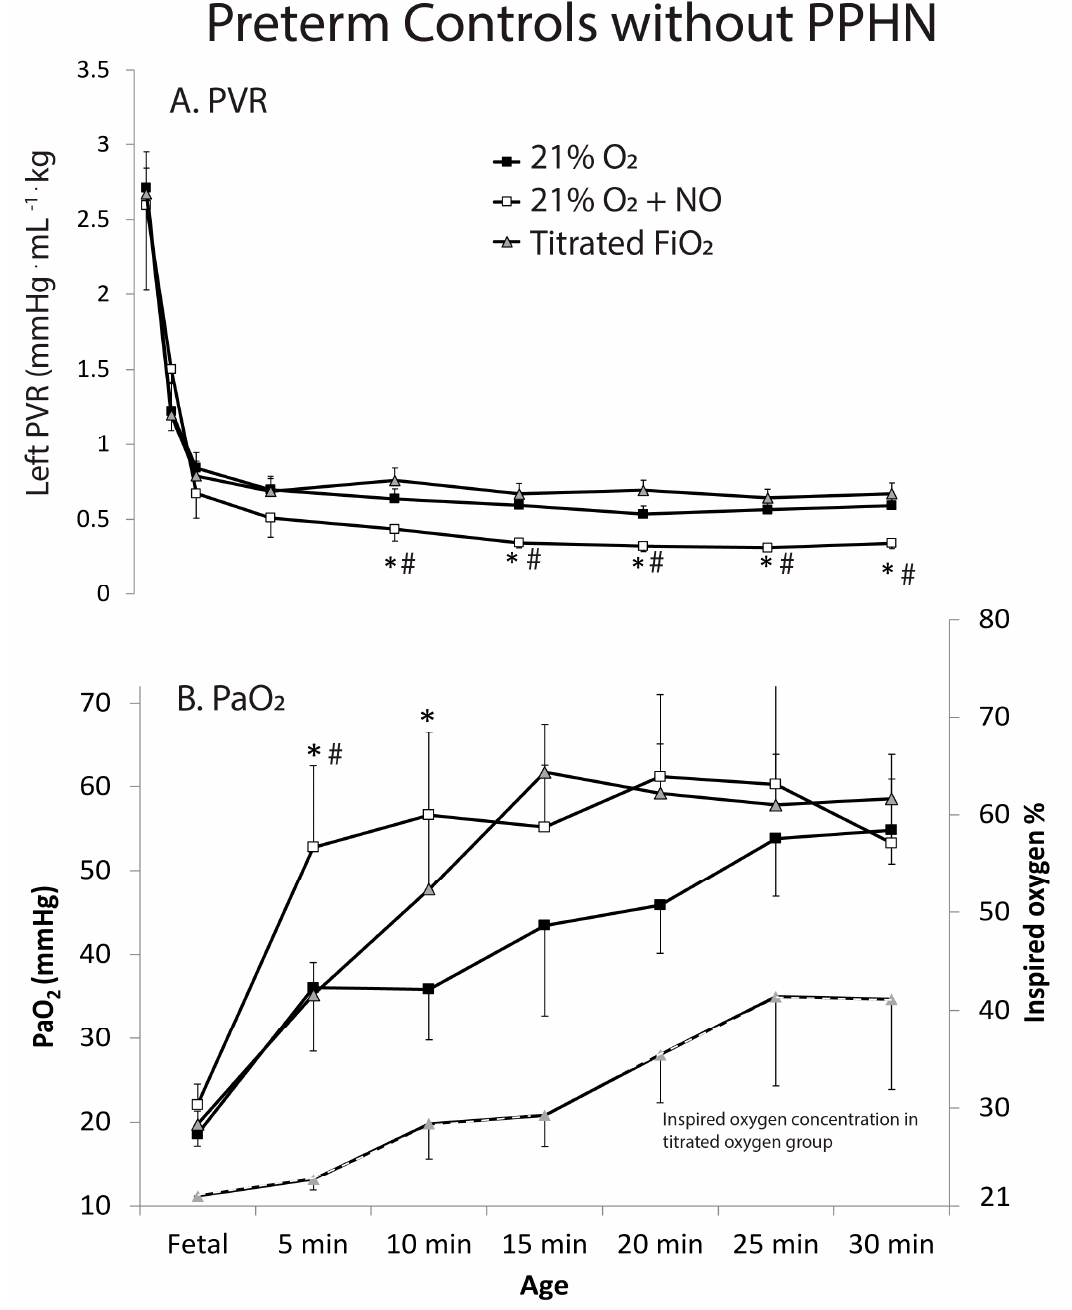
Figure 3. Changes in Pulmonary vascular resistance (PVR) in left lung ( A ) and PaO 2 ( B ) in preterm lambs exposed to 21% oxygen (solid squares) vs. 21% oxygen and iNO (open squares) and titrated oxygen (gray triangles). Inspired oxygen concentration needed in the titrated oxygen group to maintain PaO 2 between 45 to 80 mmHg is shown by a hyphenated line on the secondary y -axis (gray triangles). * p < 0.05 compared to 21% oxygen group; # p < 0.05 compared to titrated oxygen